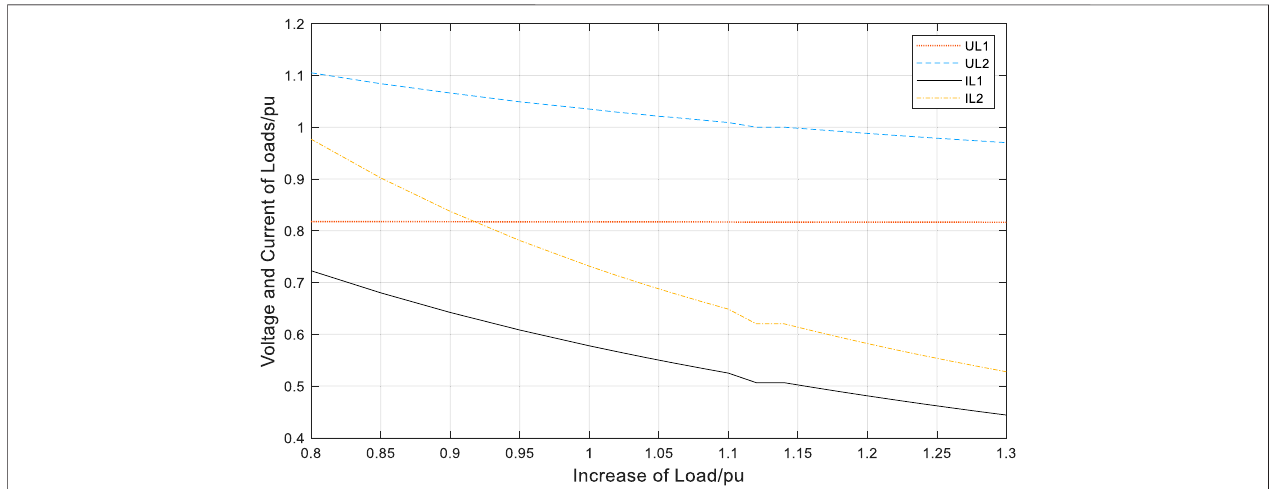
FIGURE 12 | Voltage and current curves on load with the increase of load of the improved APME model.